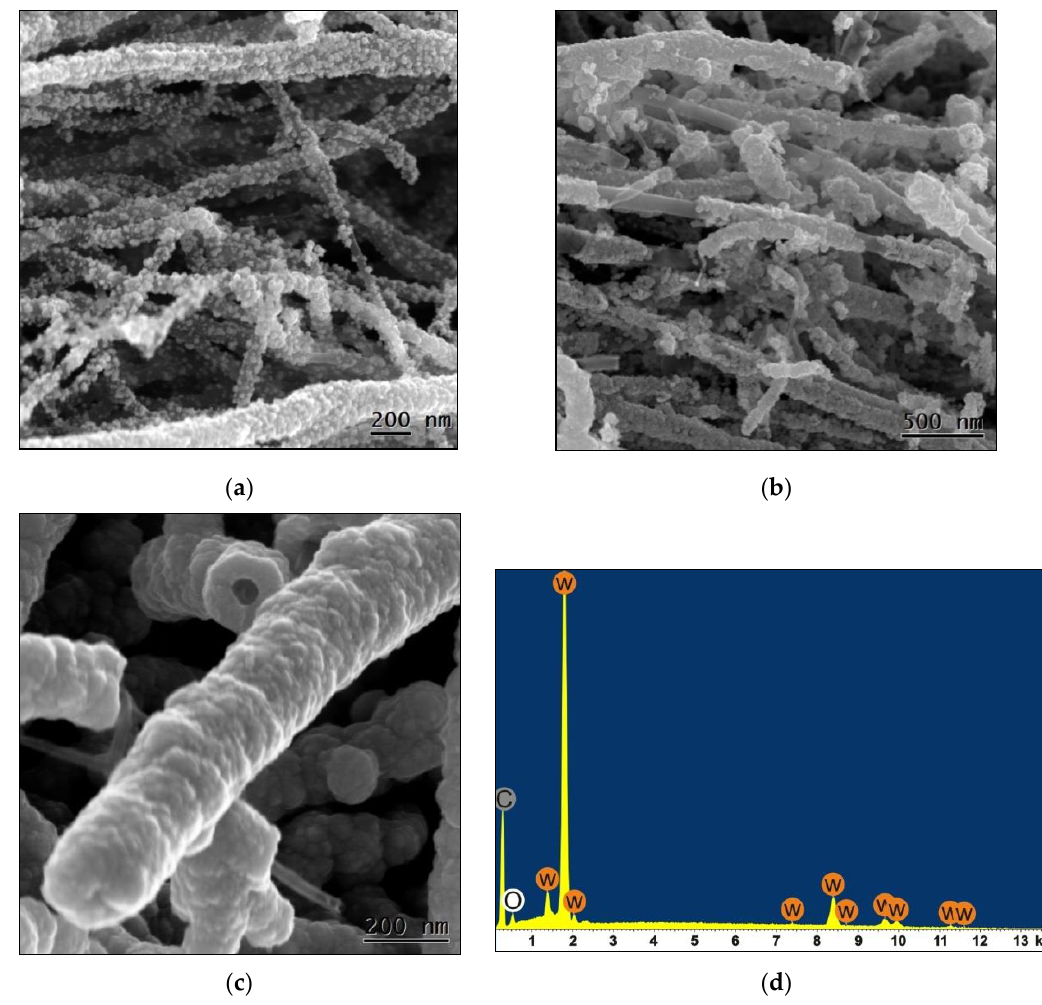
Figure 3. The SEM images of the composite material sample coated with pyrolytic tungsten carbide MWCNTs with initial mass ratios of precursors (MWCNTs:W(CO) 6 ) of 1:3 (sample 1) ( a ), 1:4 (sample 2) ( b ) and 1:5 (sample 3) ( c ). ( d )—the decrypted EDS profile obtained from the MWCNT coating shown in ( c